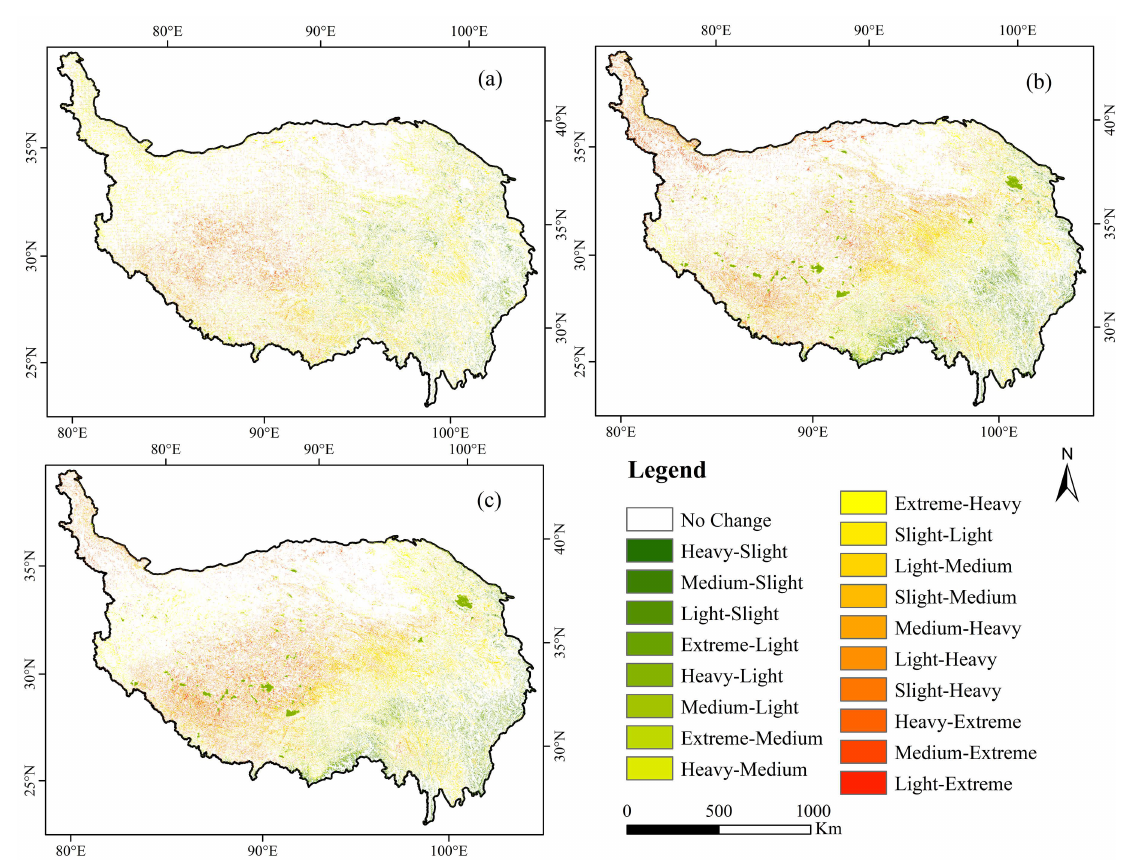
The EVI Global Moran Index for 2005, 2010 and 2015 passed the significance test, Figure 6. Temporal variations in ecosystem vulnerability on the Qinghai-Tibet Plateau in ( a ) 2005–2010, ( b ) 2010–2015, ( c ) 2005–2010.